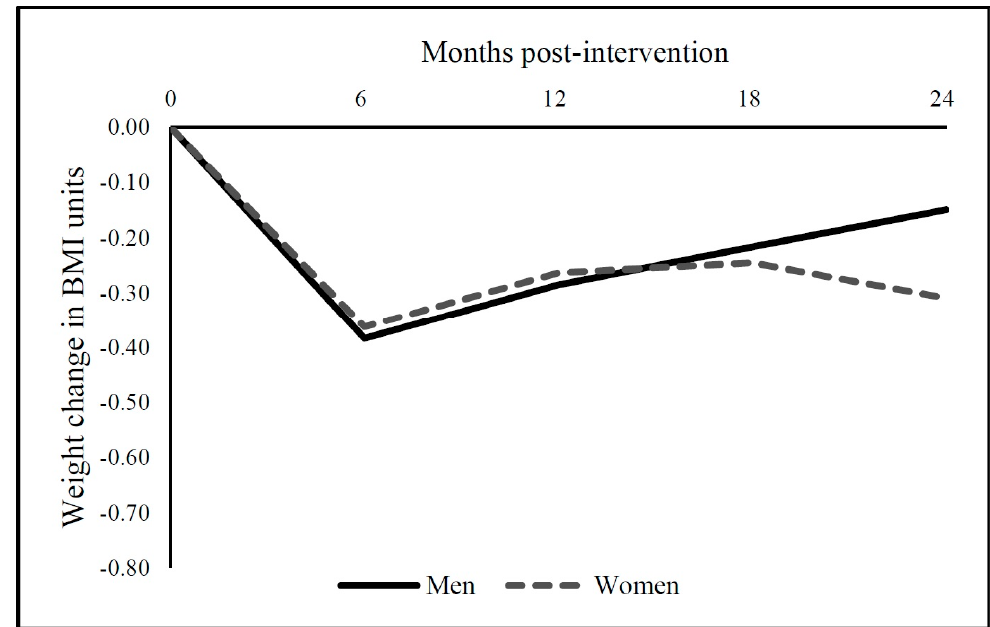
Figure 1. MOVE! effect on initial 6-month BMI change and on longer-term BMI change at 12, 18, and 24 months, separately for men and women. Statistically significant initial MOVE! effect at 6 months for men ( − 0.383, p < 0.001) and women ( − 0.362, p < 0.001) and incremental changes at 12 months for men (0.098, p < 0.001) and women (0.099, p < 0.05); and for men at 18 months (0.069, p < 0.001) and at 24 months (0.067, p < 0.001). These are difference-in-difference estimates of the effect of MOVE! on BMI change from ordinary least squares (OLS) regression models with person and calendar time fixed effects and the following covariates: marital status, 10 chronic health conditions, census tract median